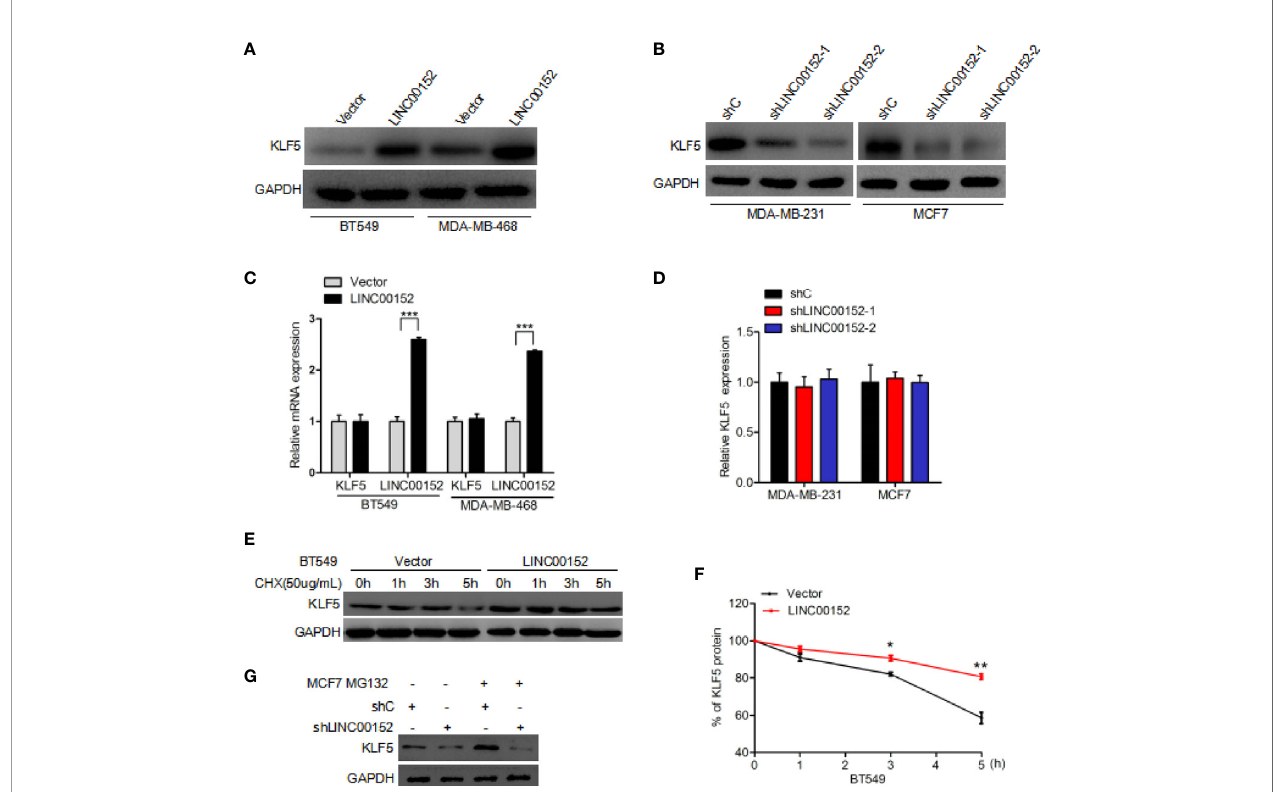
FIGURE 4 | LINC00152 regulates KLF5 protein stability. (A) Overexpression of LINC00152 increases the expression level of KLF5 protein. (B) Knockdown of LINC00152 suppresses KLF5 protein expression. (C) qRT-PCR analysis of effect of LINC00152 overexpression on KLF5 mRNA expression. (D) qRT-PCR analysis of effect of LINC00152 depletion on KLF5 mRNA expression. (E) Effect of LINC00152 overexpression on KLF5 degradation. Cycloheximide (20 mg/ml) was added to treat cells for the indicated time. (F) Quanti fi cation of KLF5 protein expression in (E) . (G) Effect of LINC00152 depletion on KLF5 degradation. MG132 was added to treat cells for the indicated time. *P < 0.05, **P < 0.001. Error bars represent SD. Data are representative of three independent